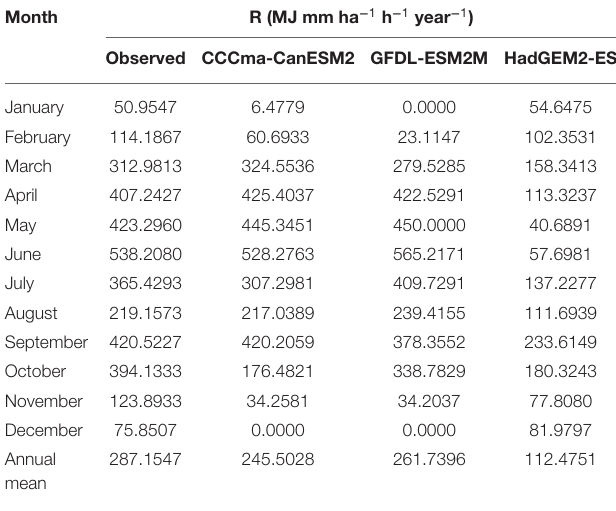
TABLE 2 | Rated soil physical characteristic of soils of the study site. Soil series Slope (%) Drainage Texture Effective soil depth (mm) Boamang Sandy loam > 200